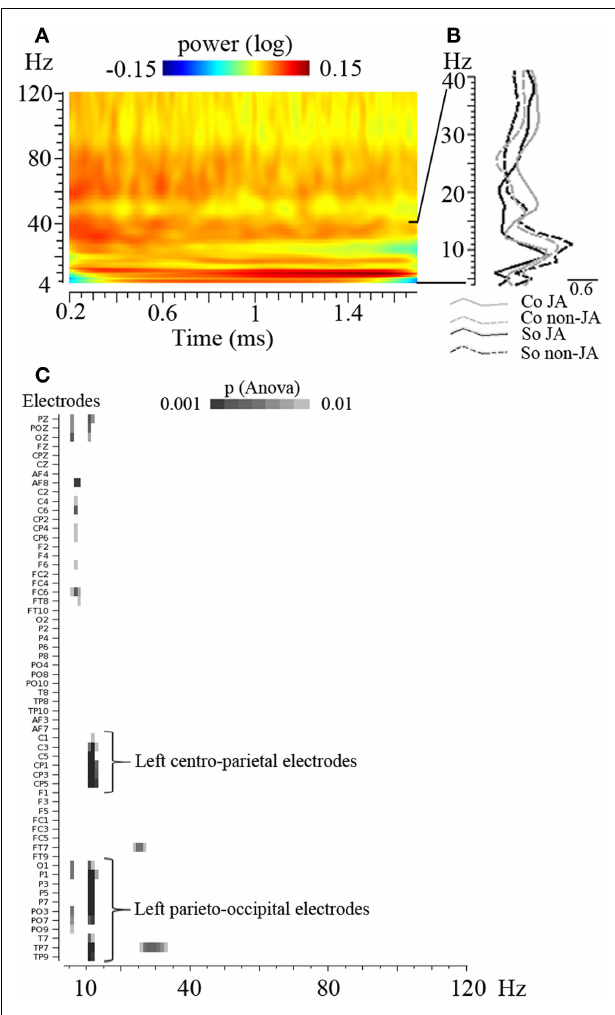
electrodes P5, P3, P1, PO7, PO3, and O1. The symmetrical